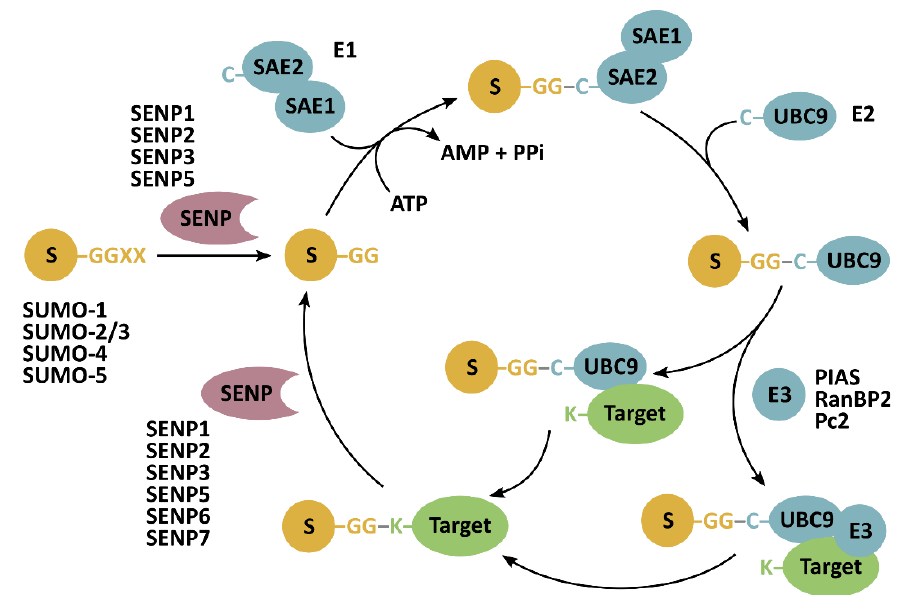
Figure 1. SUMOylation and deSUMOylation mechanism. Sentrin-specific proteases (SENP) have endopeptidase activity to cleave SUMO (S) preproteins, exposing their carboxy-terminal diglycine (GG) motif essential for their conjugation to lysine residues (K) in target proteins. SUMOylation is catalyzed by SAE1-SAE2 (heterodimeric SUMO-activating enzyme) (E1) and ubiquitin-conjugating enzyme 9 (UBC9) (E2). An E3-ligase can facilitate the last step of SUMO conjugation. SENPs isopeptidase activity allows for the release of SUMO from target proteins.